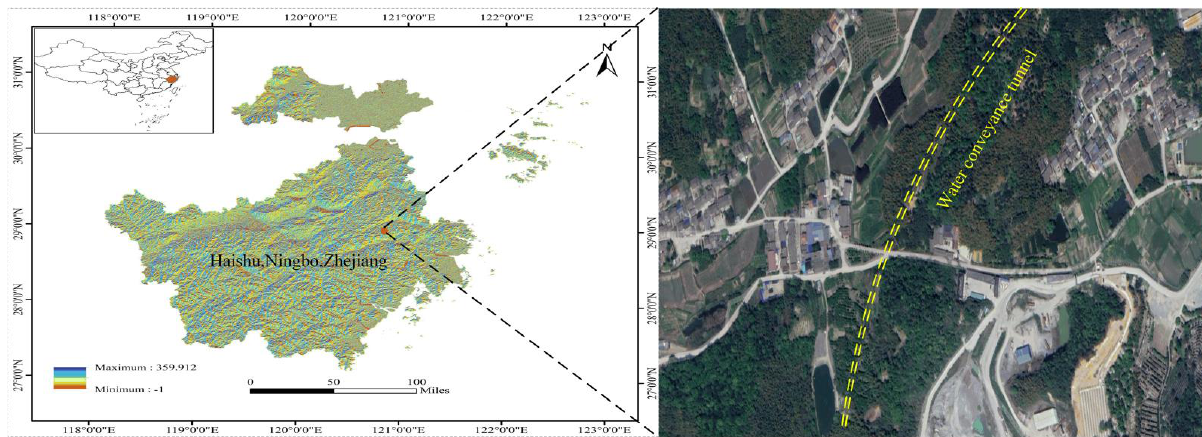
Figure 1. Geographic location map.